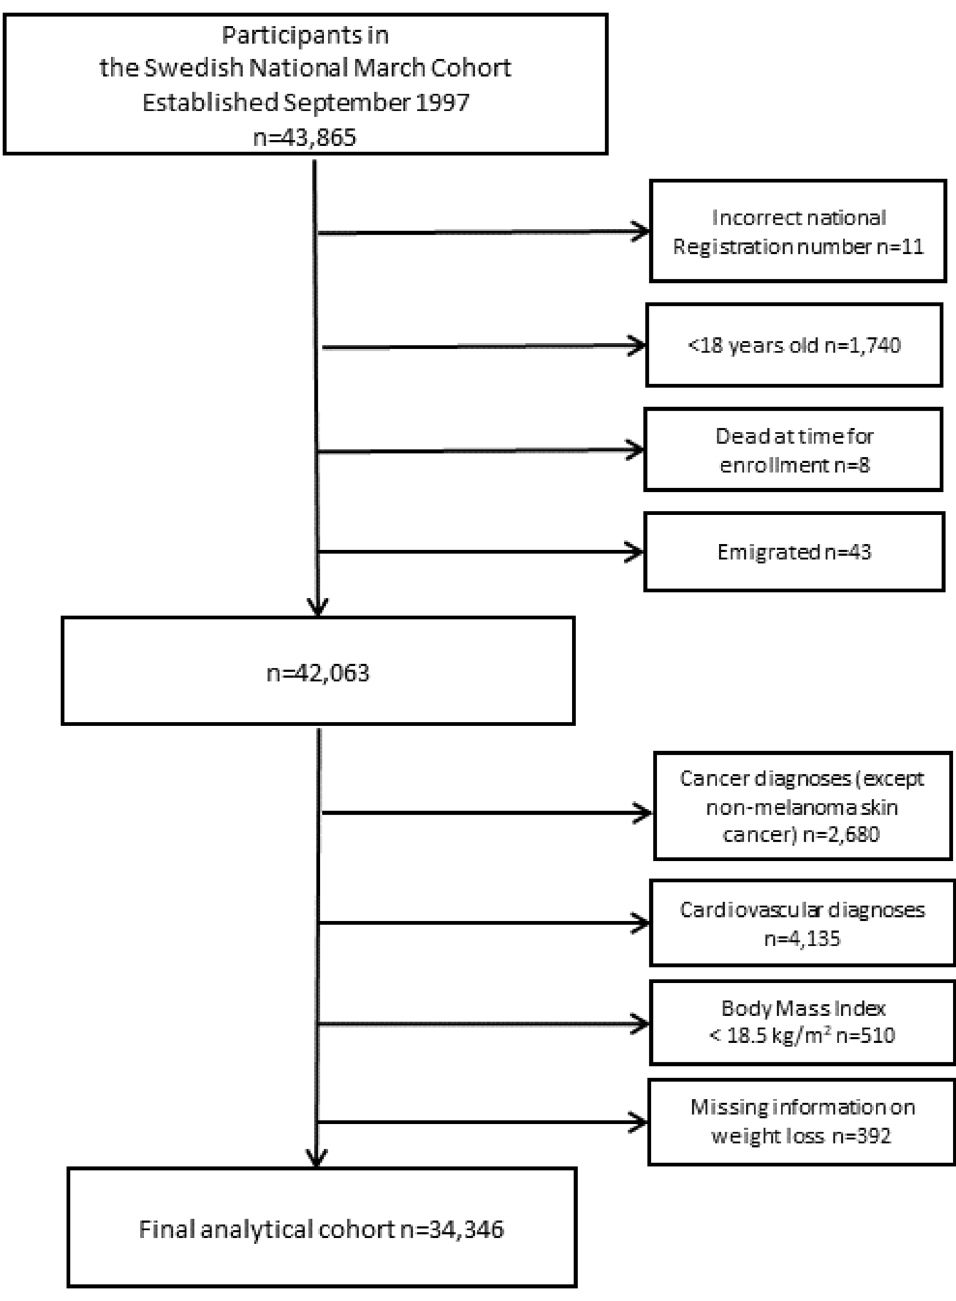
Figure 1. A flow-chart of study sample baseline exclusions and building the final analytical